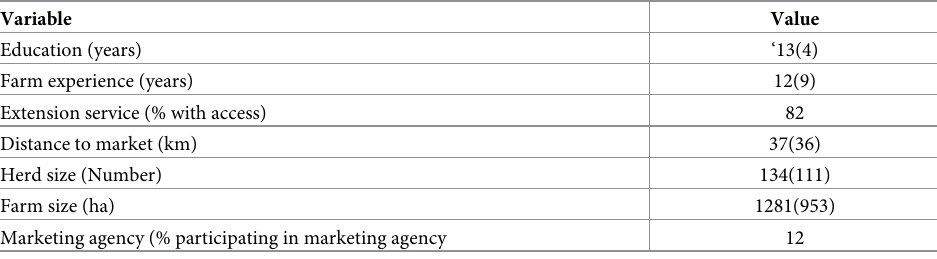
Table 2. Levels of model variables (n = 50).